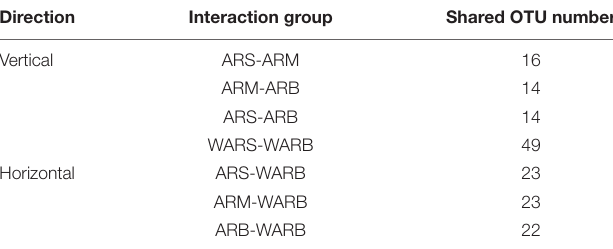
TABLE 2 | Shared OTU number between different interaction groups.